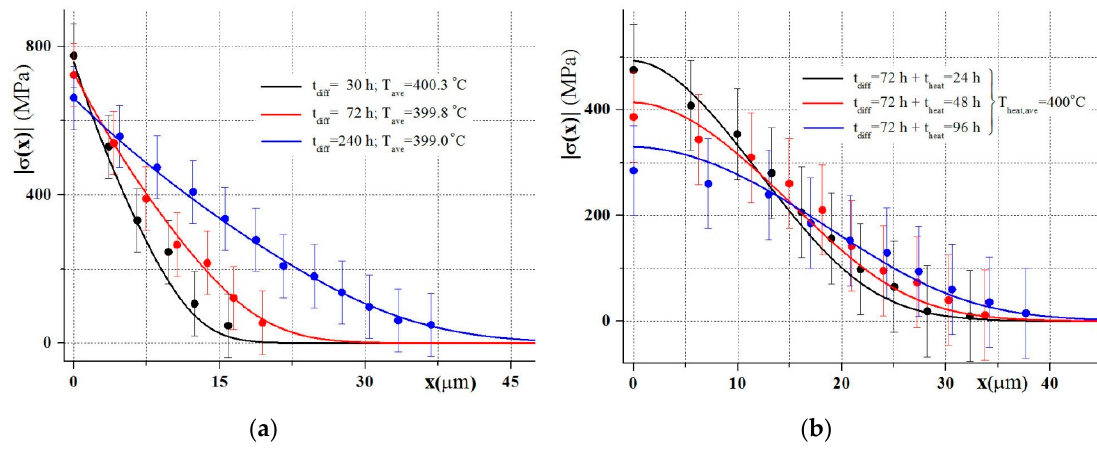
Figure 9. A comparison of simulation results of the σ ( x ) function and the measurements ( λ = 677 nm) of ( a ) diffusion processes, ( b ) heating processes.